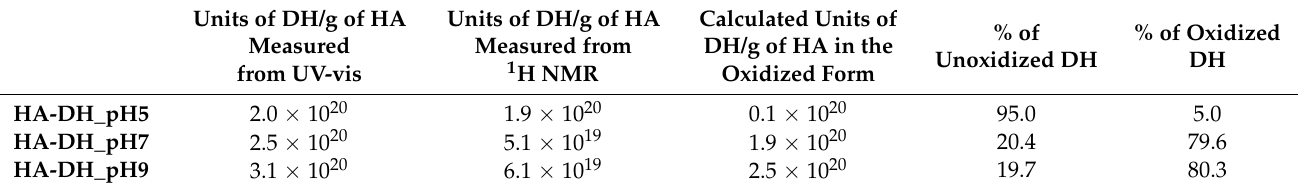
Table 1. Units of DH molecules per g of polymer measured from UV-vis and 1 H NMR spectroscopic analyses performed on HA-DH_pHX samples. Percentages of DH molecules grafted to the HA backbone in the oxidized and unoxidized